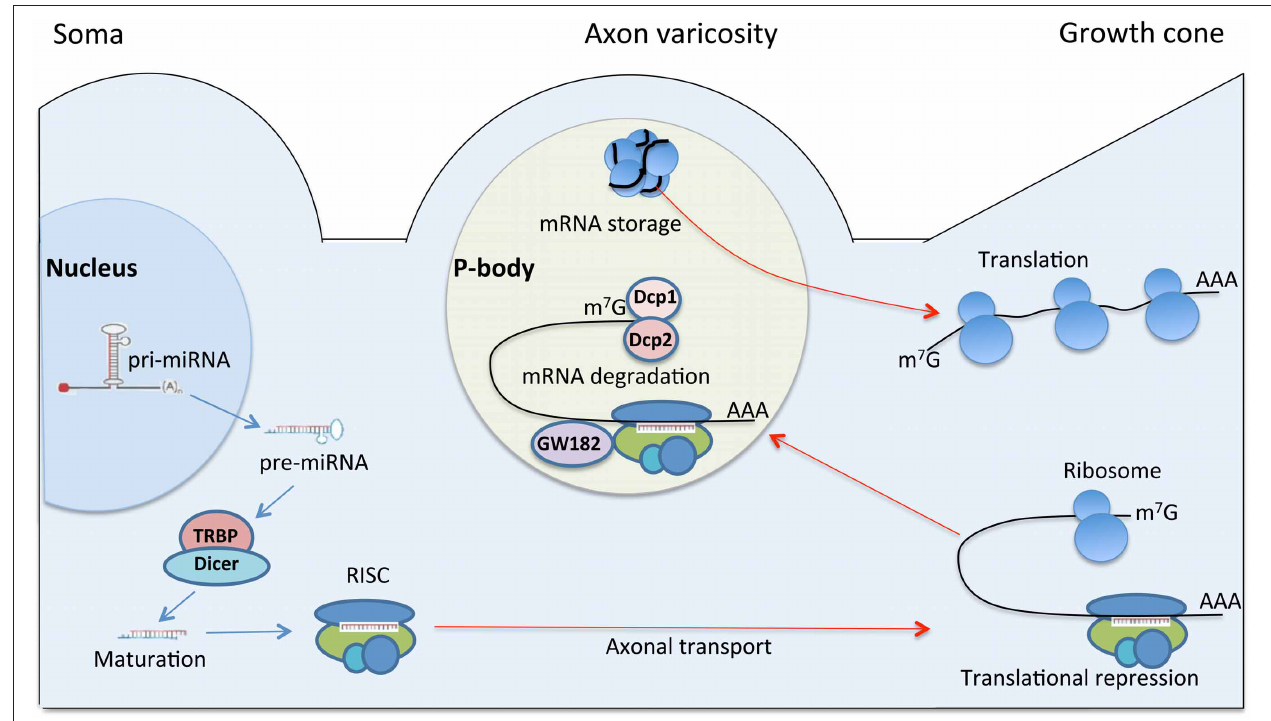
FIGURE 3 | A model for regulation of axonal protein synthesis by miRNA in regeneration. The illustration depicts neuronal cell body, axon varicosity and the growth cone. Pri-miRNA is transcribed in the nucleus and transported to cytoplasm as pre-miRNA. In the cytoplasm, pre-miRNA is processed by Dicer/TRBP complex into mature miRNA, which is loaded onto RISC. RISC is a nucleoprotein complex, which may be transported to distal regions of neuron including the growth cone. In the growth cone RISC may regulate protein translation by silencing specific mRNAs and causing translational repression. The repressed mRNAs may translocate into P-body, a specific foci, primarily localized to axon varicosities. Axon